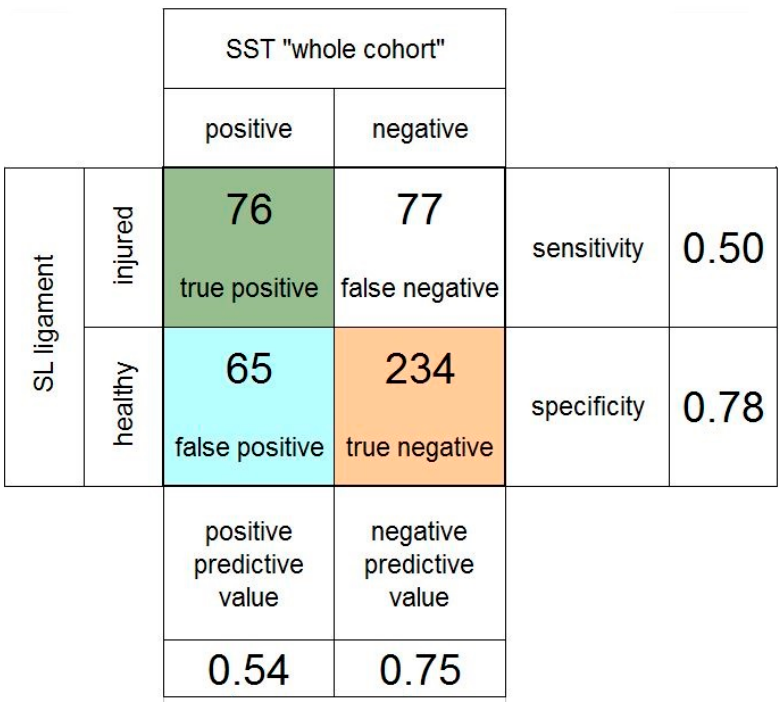
Figure 4. Fourfold table of the scaphoid shift test (SST) in the whole cohort of patients. SL: